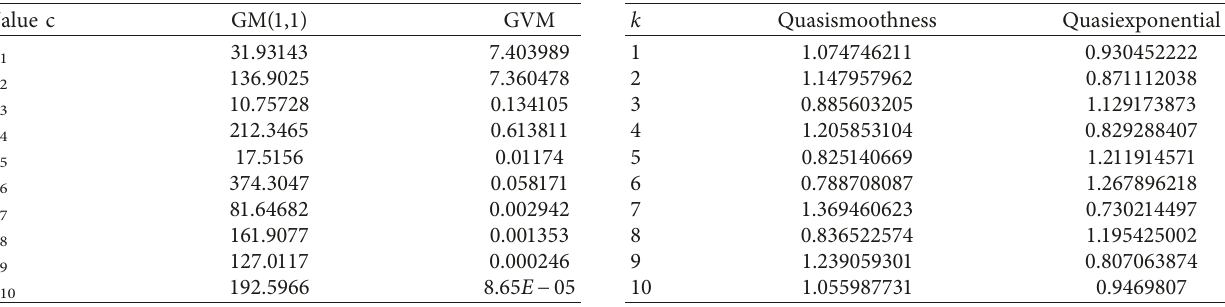
Figure 3: The comparison of MAPE of GM(1,1) (%) with MAPE of GVM (%). Table 4: Calculation of c -value of GM and GVM. Table 5: Result x (1) ( k ) of quasismoothness and